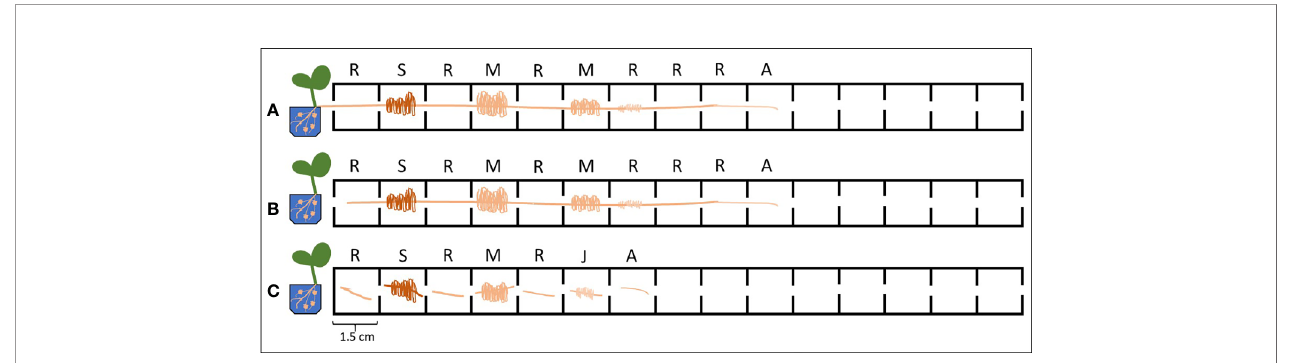
FIGURE 3 | Different experimental set-ups used for the P i uptake/exudation experiment. Letters above the cells indicate the root tissue type: R, root without cluster; S, senescent cluster root; M, mature cluster root; J, juvenile cluster root; A, apex. (A) Intact plants (IP): without cutting the root apparatus from the shoots nor dissecting the root into smaller root sections. (B) Intact roots (IR): separating the roots from the shoots, without dissecting the root into smaller root sections. (C) Dissected roots (DR): separating the roots from the shoots and dissecting the roots in different